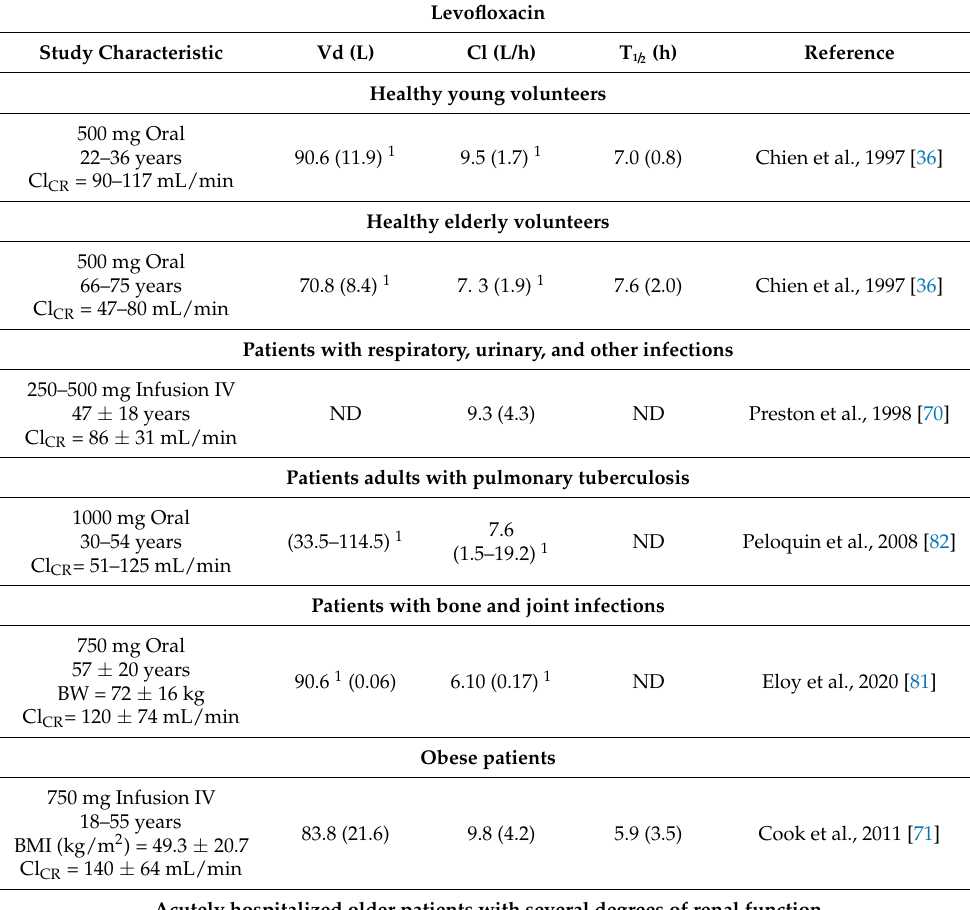
Table 2. Steady-state pharmacokinetic parameters for levofloxacin in patients with several phys- iopathology conditions after intravenous or oral administration (values expressed as mean (standard deviation) or mean (range) when standard deviation is not